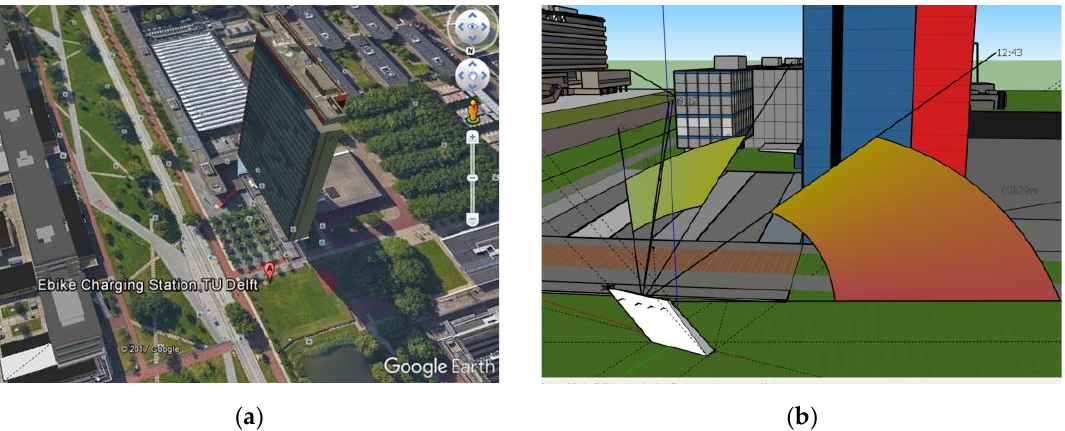
Figure 6. ( a ) Google Earth image showing the station location and nearby building. ( b ) Calculation of the shading factor due to nearby buildings using Sketchup.